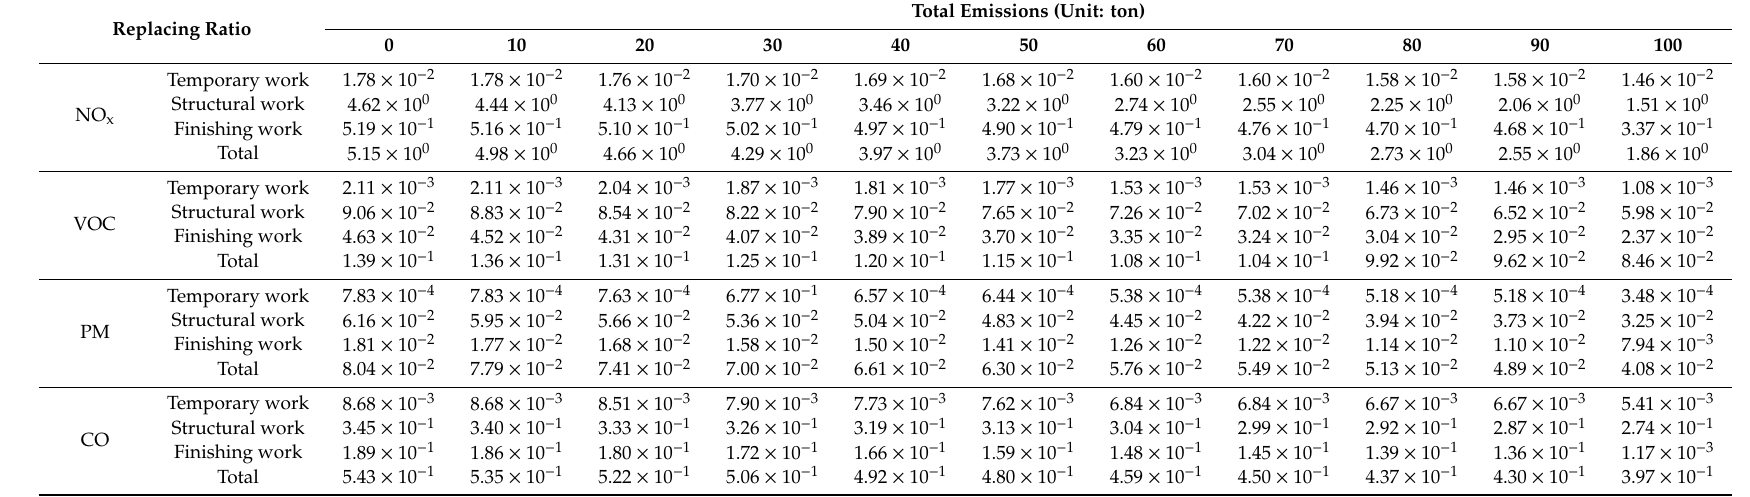
Table 7. Variations of pollutant emissions for the four road